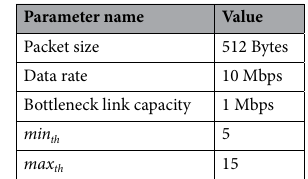
Table 2. The parameter values of the implemented